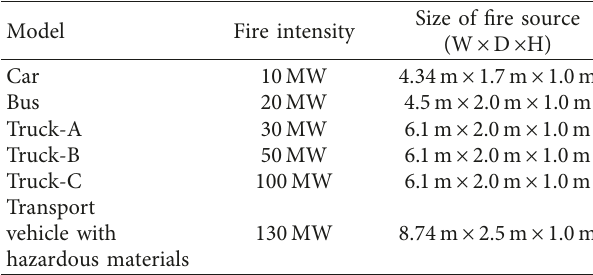
Table 9: FDS model showing fire intensity and size of fire